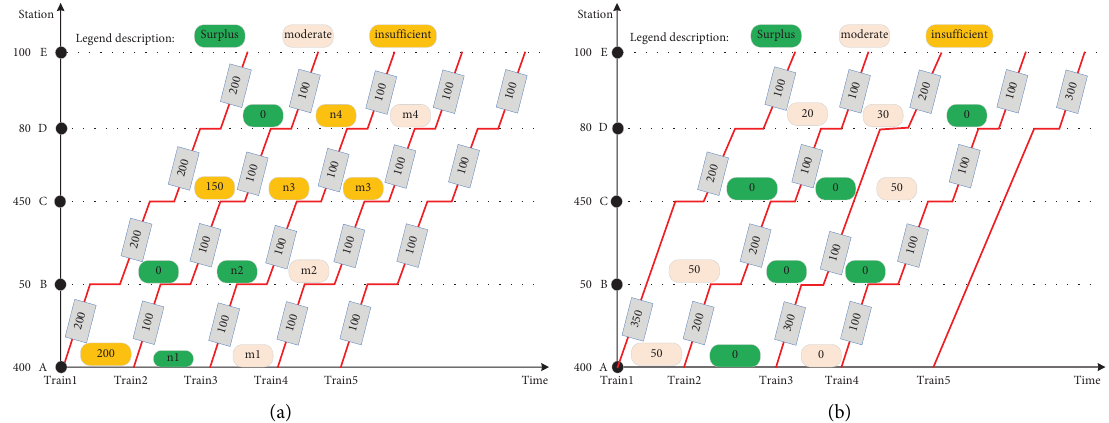
Figure 2: Te passenger fow status under diferent metro operation modes: (a) passenger fow in traditional operation mode; (b) passenger fow in express and local mode.